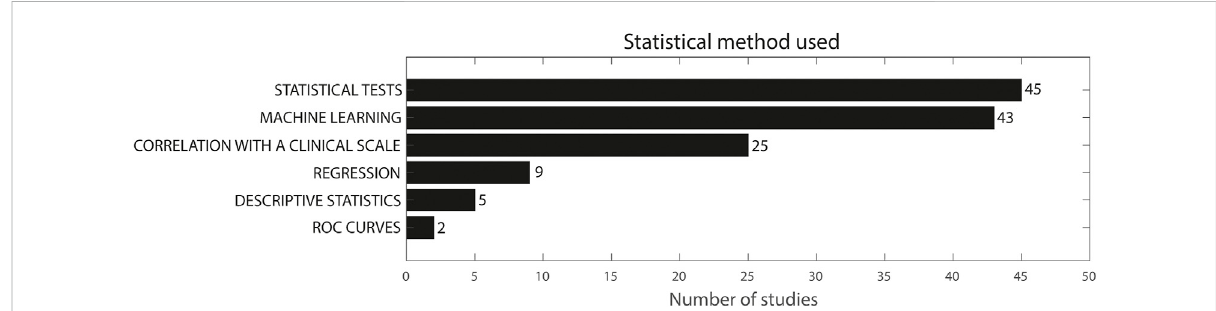
FIGURE 4 Statistical method used in the included studies. The sum does not add up to 101 because multiple studies used more than one methodology.